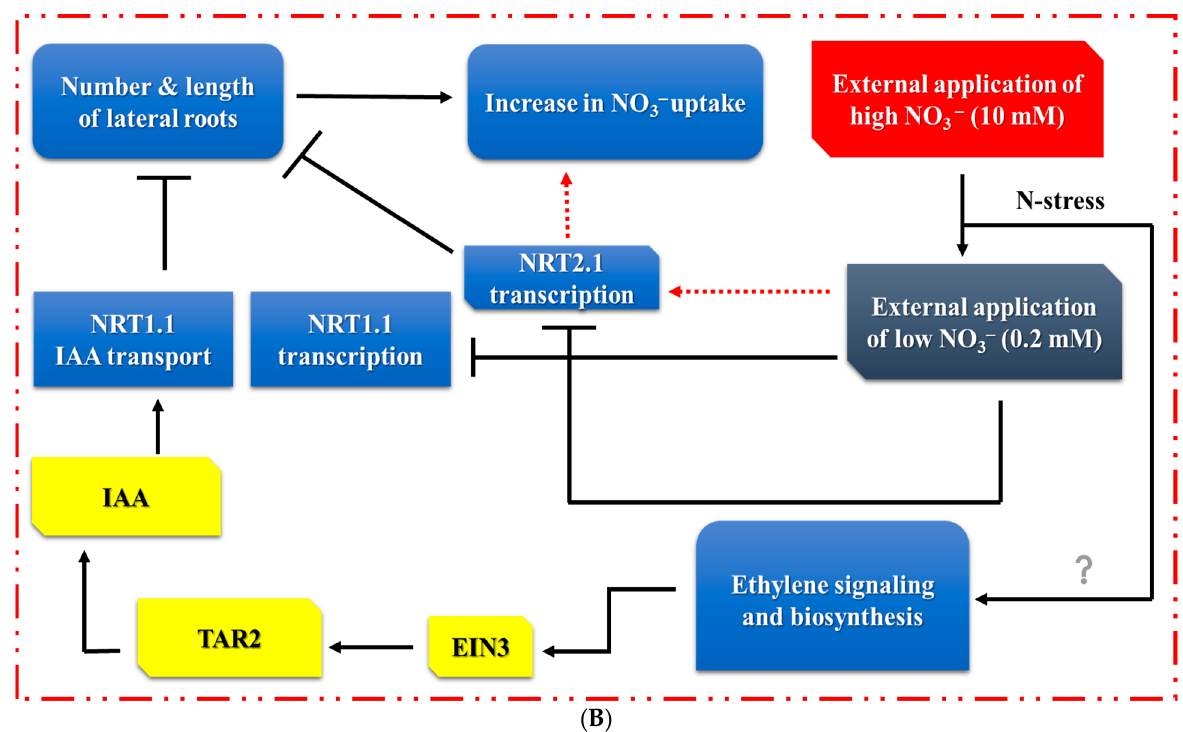
Figure 4. Effect of short-term ethylene biosynthesis, expression of NRT genes, and Arabidopsis root system architecture. ( A ) Changes in ethylene via nitrate concentration upregulate AtNRT1.1 and down-regulate AtNRT2.1 (adapted from [149]). ( B ) Sudden change in ethylene by the deprivation of external NO 3 − in the medium down-regulates the transcription of AtNRT2.1 . According to this model, the ethylene signaling component will be involved in the de-induction of the AtNRT2 gene (adapted from [41]). Arrows and blunted lines indicate positive and negative gene expression control, respectively. Dotted arrows show temporary regulation, while a question mark indicates an unknown signaling mechanism (?).